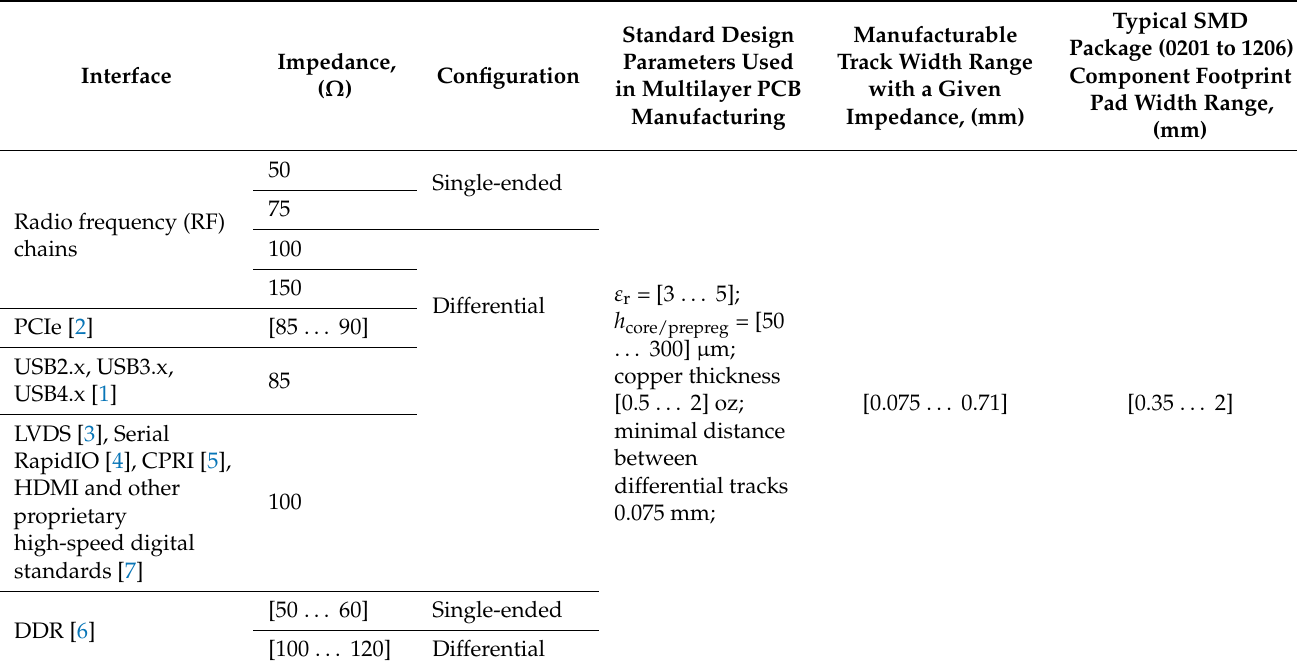
Table 1. A summary of modern analog and digital interface impedances and typical multilayer PCB track width